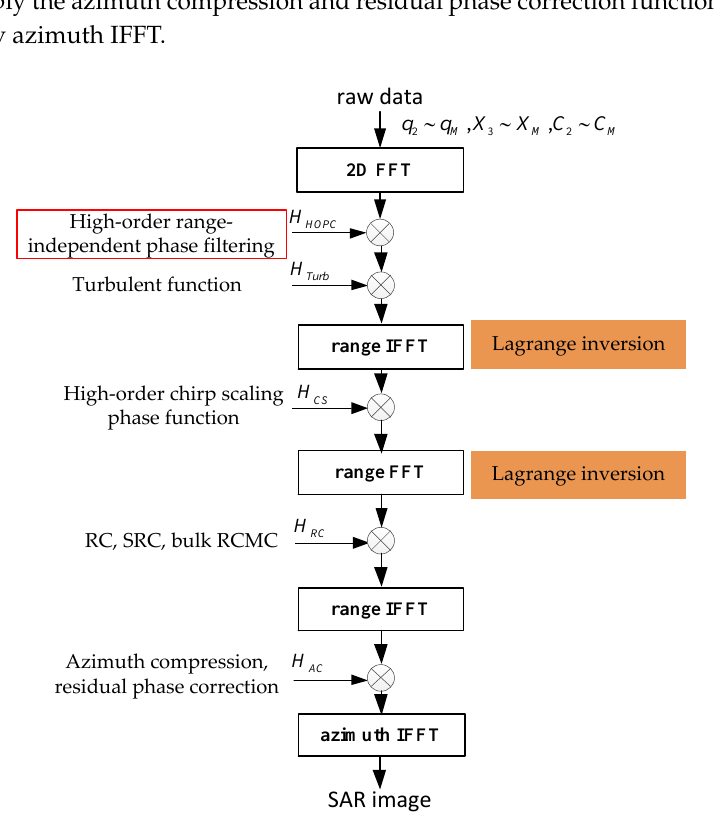
Figure 5. The flow chart of the proposed